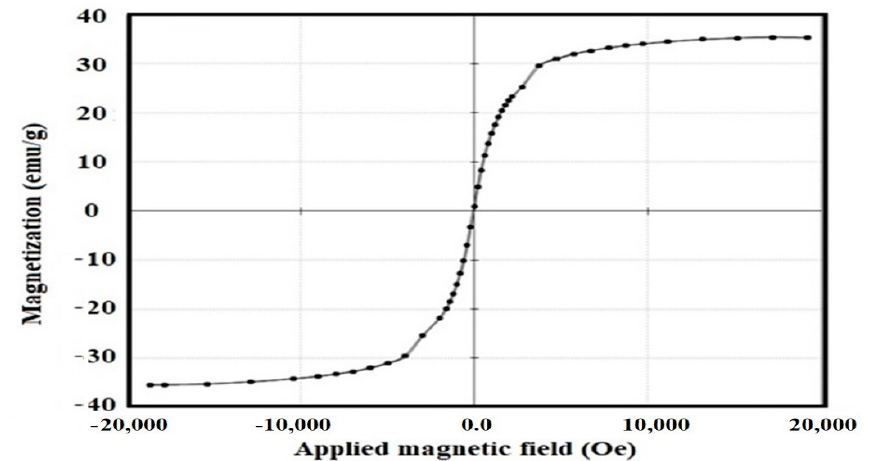
Figure 8. Vibrating sample magnetometer (VSM) hysteresis of the Fe 3 O 4 -Si-IL hybrid at room temperature.